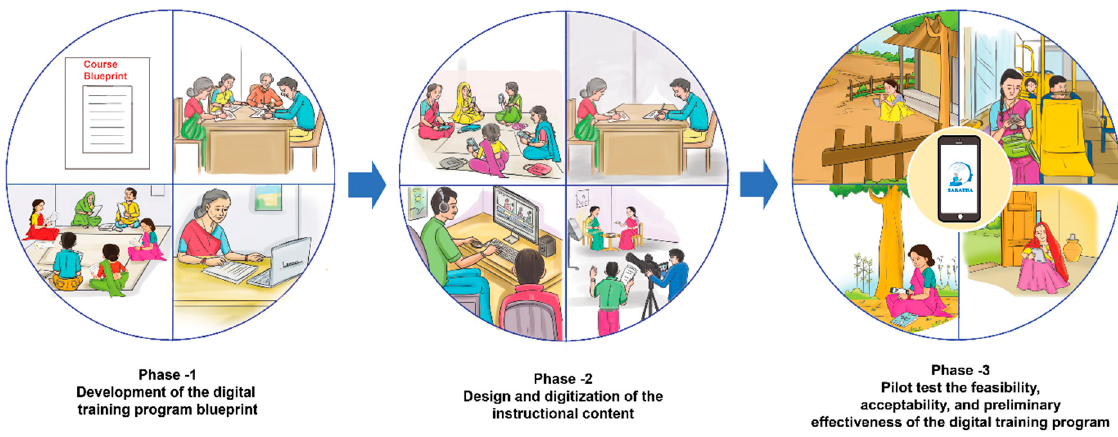
Figure 1. Stepwise approach for intervention